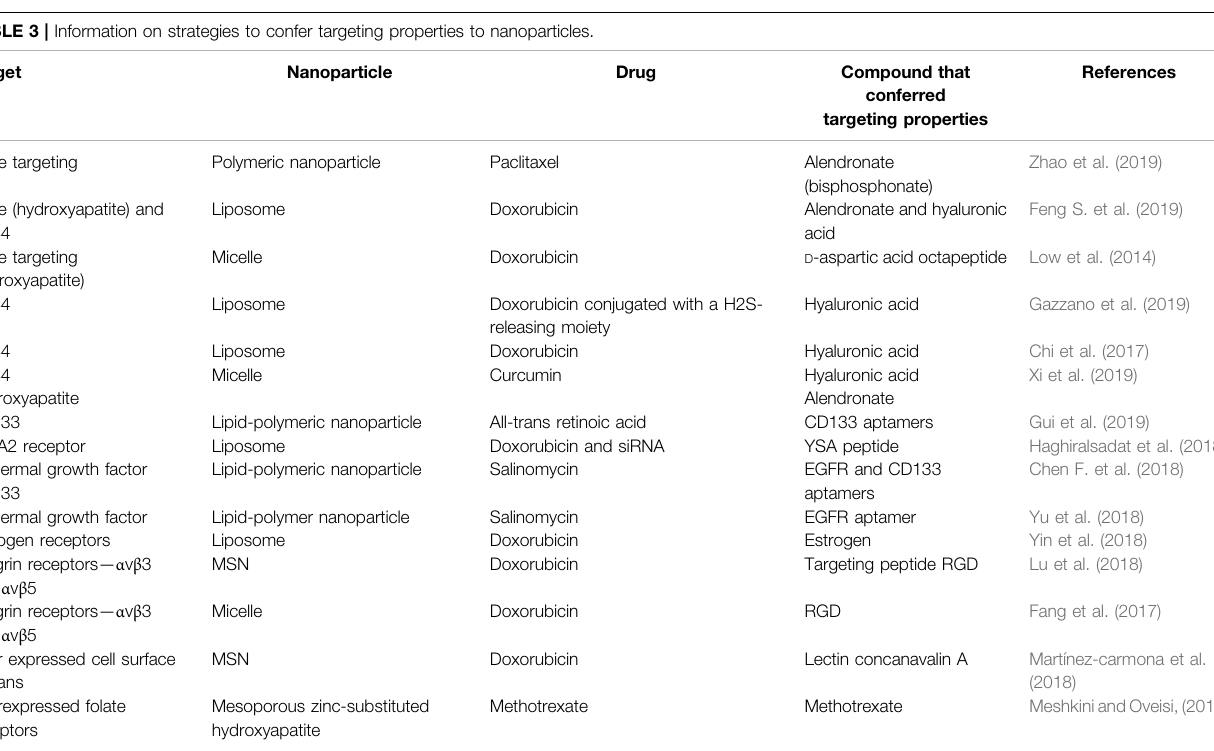
TABLE 3 | Information on strategies to confer targeting properties to